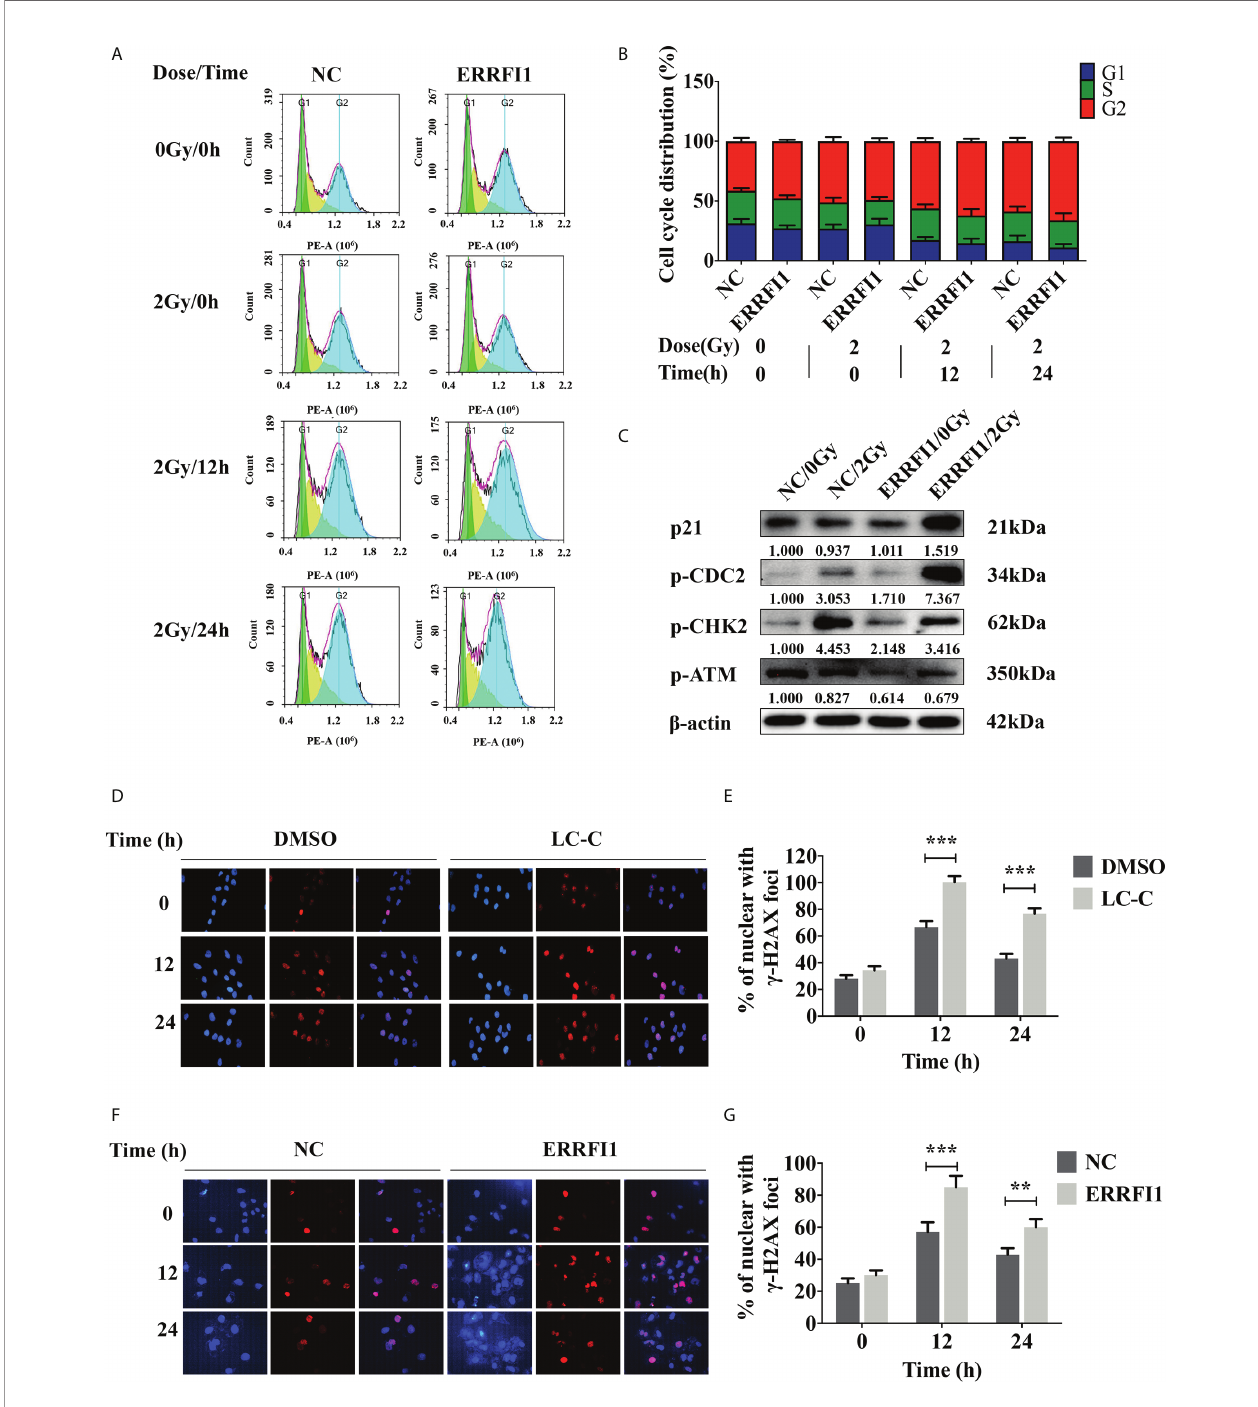
FIGURE 5 | ERRFI1 promotes G2/M cell cycle arrest and LC-C/ERRFI1 blocks IR-induced DNA doublestrand break repair in A549-IR cells after radiation. (A) Representative FACS images showing cell cycle distributions of ERRFI1-expressed A549-IR cells after treatment of radiation; (B) Histogram of cell cycle distribution of ERRFI1-expressed A549-IR cells after treatment with radiation; (C) Western blotting showing the changes of protein expression and phosphorylation in ERRFI1-expressed A549-IR cells after treatment with radiation; (D) Representative images of g -H2AX foci in A549-IR cells treated with LC-C and radiation ( g -H2AX labeled with red, nuclei with blue). (E) Histogram showing the average numbers of g -H2AX foci per cell in A549-IR cells treated with LC-C and radiation. (F) Representative images of g -H2AX foci of ERRFI1-expressed A549-IR cells after treatment of radiation ( g -H2AX labeled with red, nuclei with blue). (G) Histogram showing the average numbers of g -H2AX foci per cell of ERRFI1-expressed A549-IR cells after treatment with radiation. Results shown are the means ± standard deviations. **Signi fi cant difference at P < 0.01 level. ***Signi fi cant difference at P < 0.001